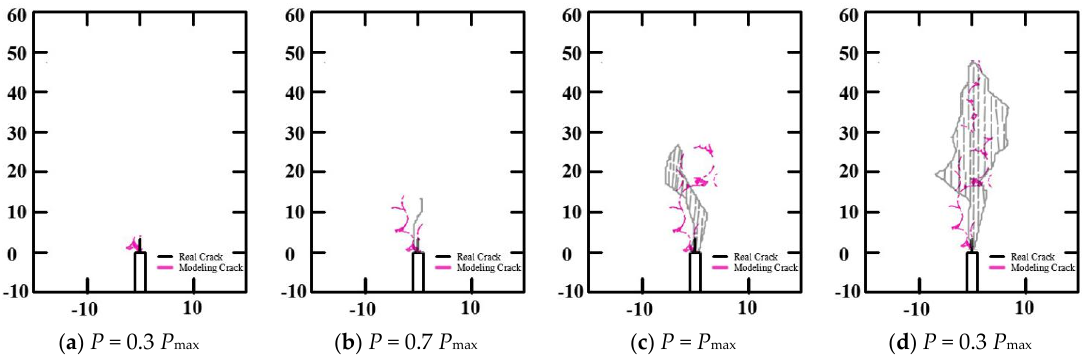
Figure 4. Evolution process of the 3-p-b specimen fracture process zone.